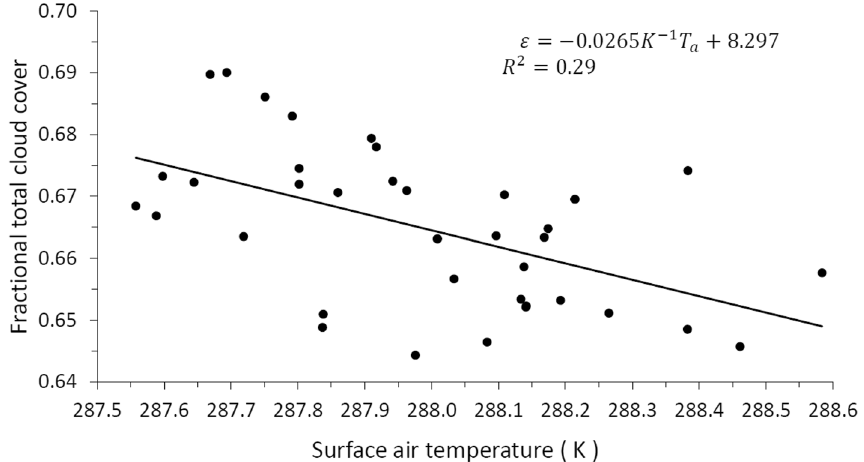
1 � T a , with the same